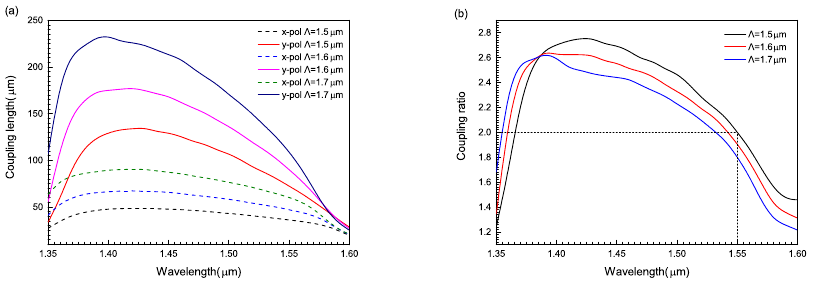
Figure 8. Influence of distance change between adjacent pores on coupling length ( a ) and coupling ratio ( b ).